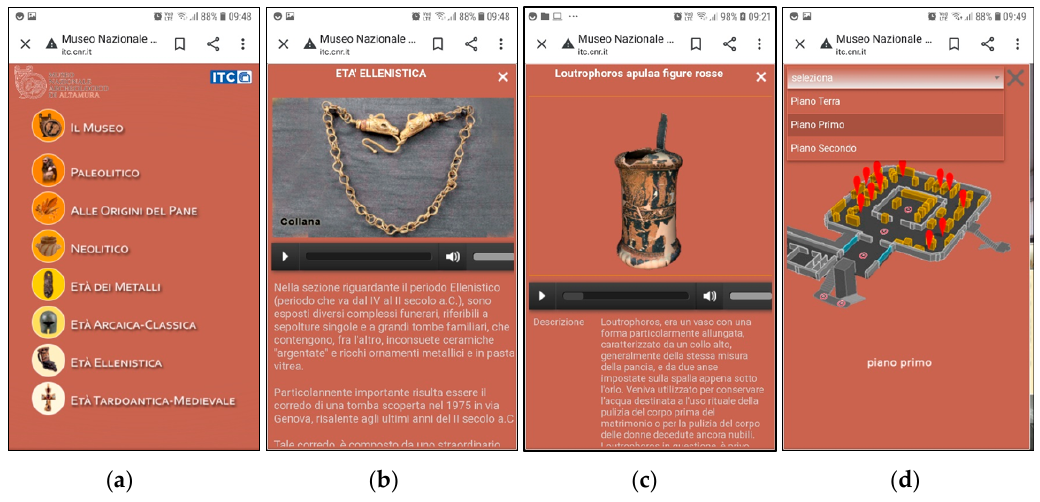
Figure 12. Virtual tour of the National Archaeological Altamura Museum [2] on mobile. ( a ) Homepage with Museum Section list. ( b ) Museum section window with an image carousel of section artifacts and a description (text and audio). ( c ) Artifact window with an area for 3D model manipulation. ( d ) 3D floorplan.